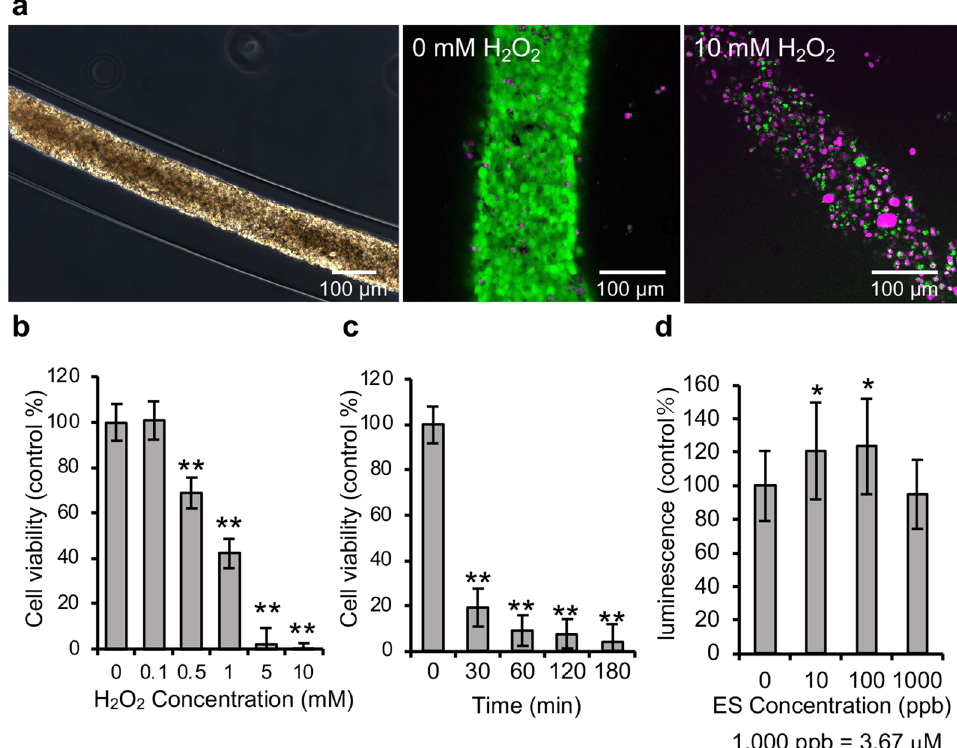
Figure 4. Cell viability of GT1-7 CF fragments following H 2 O 2 and β-estradiol treatment. ( a ) Phase-contrast image of the GT1-7 CF fragment at 10 days in culture (left). Fluorescence images of live/dead assay of GT1-7 CF fragments treated with 0 or 10 mM H 2 O 2 for 24 h after 10 days in culture (middle and right). The live and dead cells exhibited green and magenta fluorescence, respectively. ( b ) Graphs of cell viability after treatment of GT1-7 CF fragments at 10 days in culture with various H 2 O 2 concentrations (0–10 mM) for 24 h, ( c ) with 5 mM H 2 O 2 for 30, 60, 120, and 180 min. ( d ) Graph of the luminescence after treatment of GT1-7 CF fragments at 10 days in culture with 0–1000 ppb β-estradiol (ES) for 48 h. The experiment was repeated three times with n = 4 (** P < 0.01, * P < 0.1).